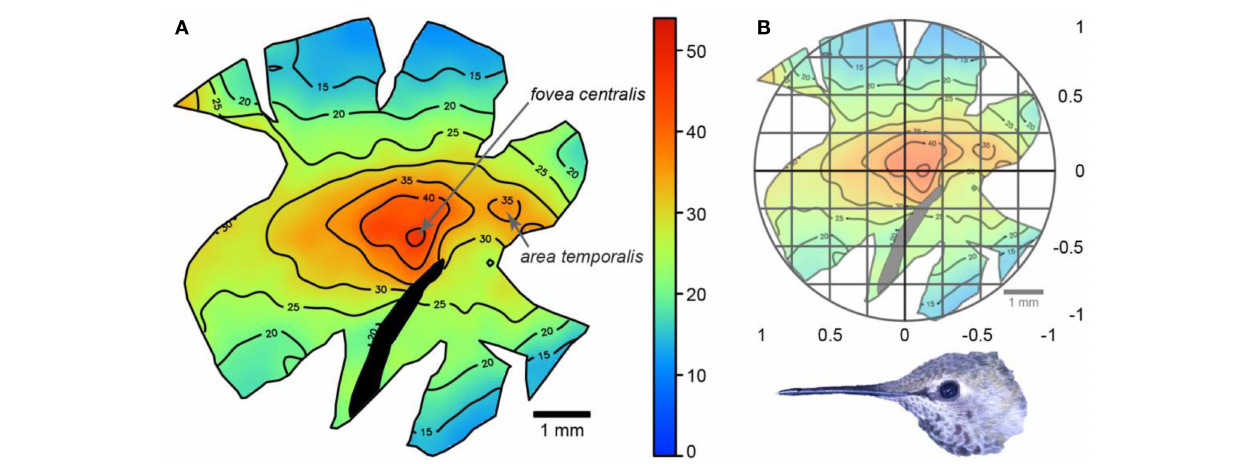
FIGURE 4 | (A) Topographic map showing retinal ganglion cell densities across a wholemount of an Anna’s hummingbird retina. The numbers represent thousands of cells/mm 2 and the black section of the retina indicates the position of the pecten. (B) The same map with an overlay of the Cartesian coordinate system. Picture shows the relative orientation of the retina relative to the bird’s